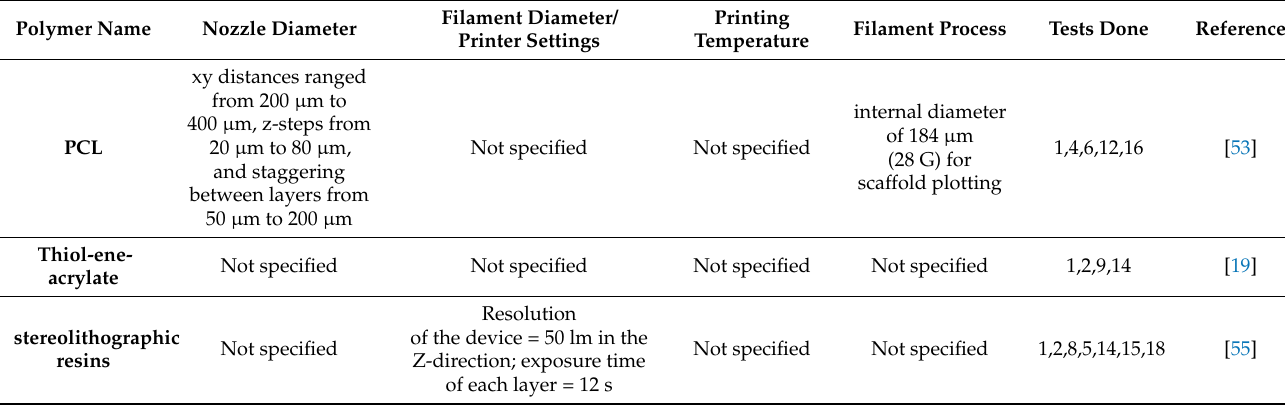
Table 2. Printing parameters used in selected